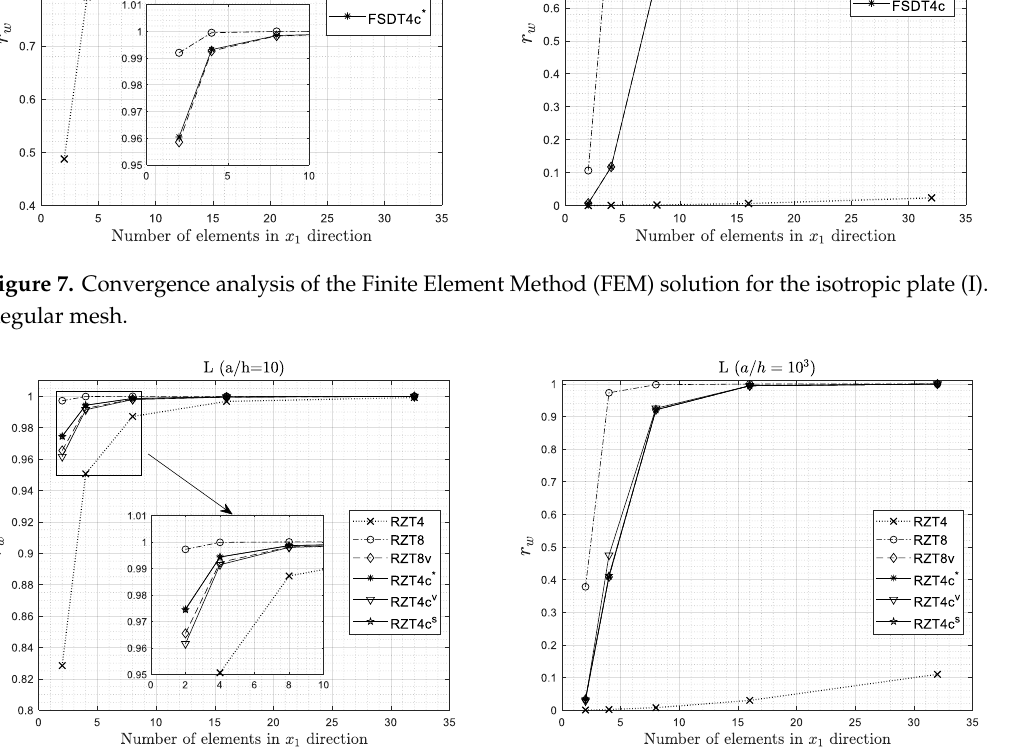
Figure 8. Convergence analysis of the FEM solution for the laminated plate (L). Regular mesh.